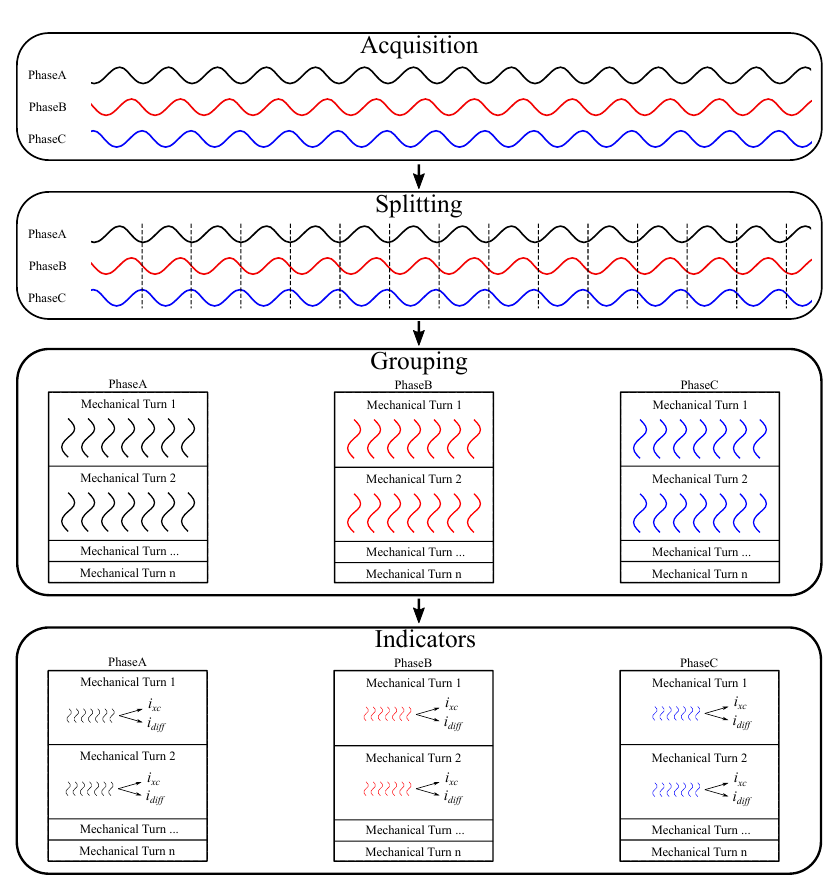
Figure 12. Procedure to obtain the